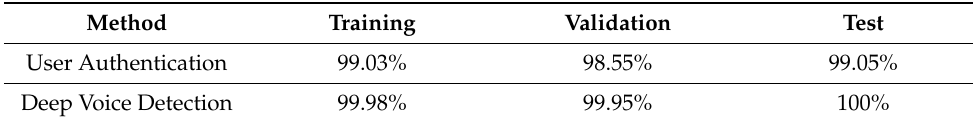
Table 4. F 1 scores for user authentication and deep voice